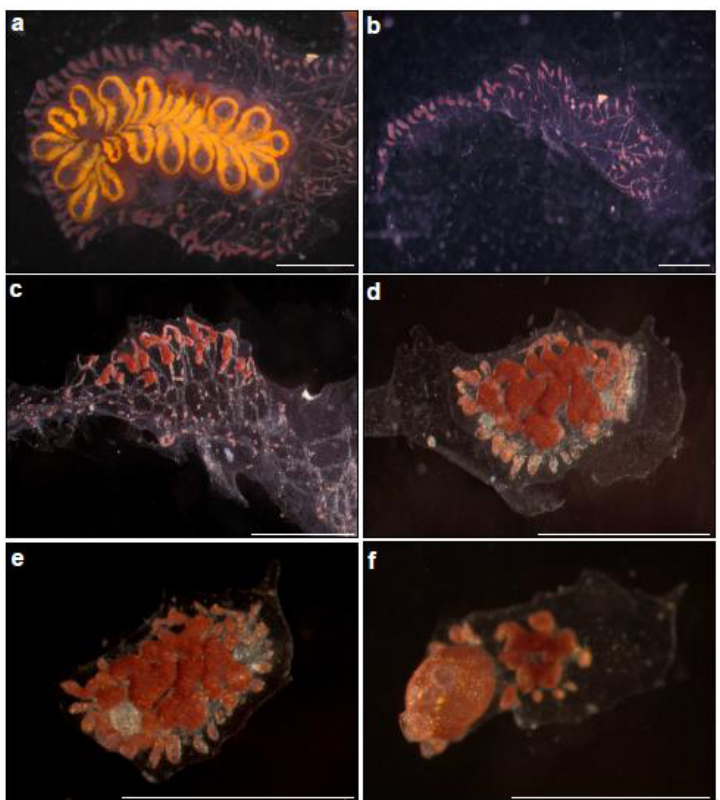
Figure 2. Whole body regeneration in Botrylloides leachi from the Mediterranean coast of Israel. ( a ) A colony growing on glass slide, just before zooids (cid:180) dissection; ( b ) Immediately after zooids (cid:180) dissection. A piece of the tunic containing marginal ampullae is left; ( c (cid:177) f ) Whole body regeneration within two weeks. ( c ) Morphological changes, three days after dissection, the tunic fragment with ampullae constructions. This is follows by the formation of bud rudiment at the middle of the fragment ( d = day 7), well developed bud ( e = day 10) and the establishment of fully functional, filtering organism (the two extending siphons are seen), containing a single zooid ( f = day